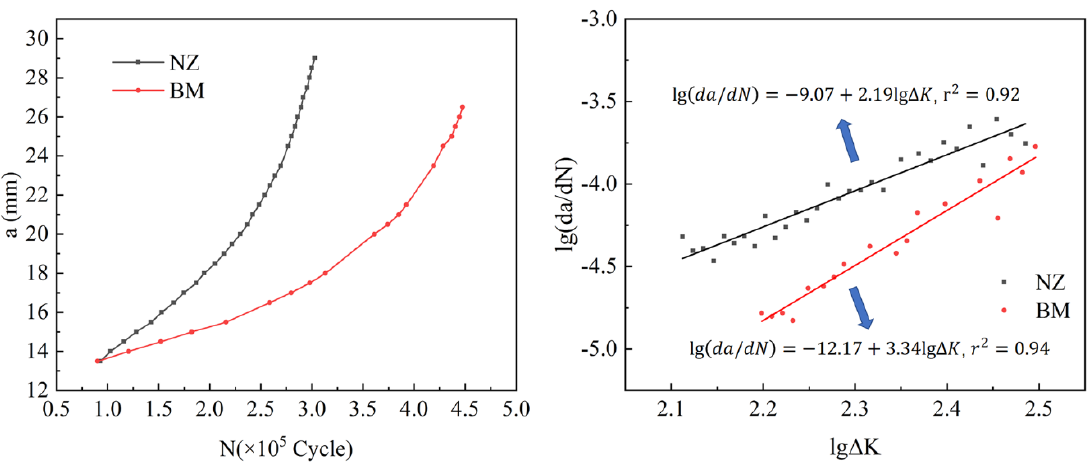
Figure 6. Results for FCP (fatigue crack propagation) test, a–N curve ( left ), and lg(da / dN)-lg ∆ K curve ( right ).